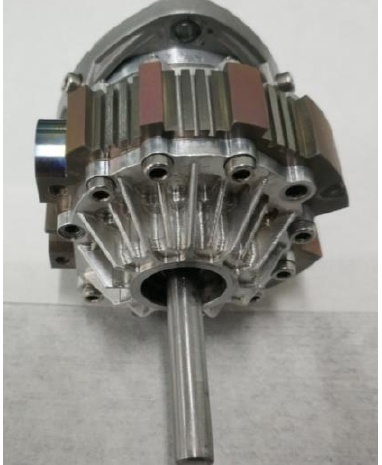
Figure 20. The assembled micro Wankel engine.